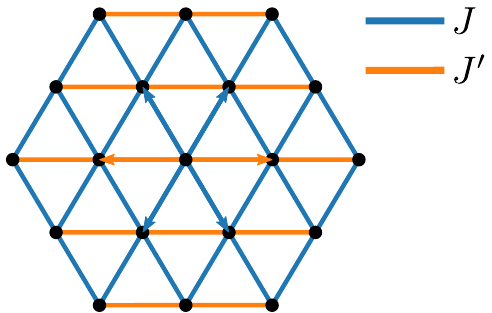
Figure 1: Spatially anisotropic triangular lattice, with J exchange interaction running along two directions (purple) and J (cid:48) running along the remaining one